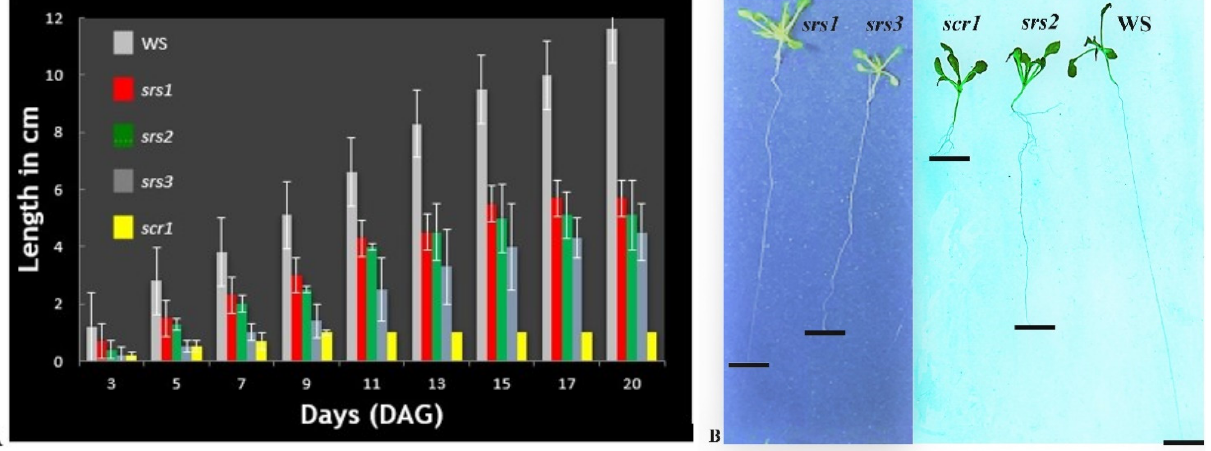
Figure 4. Root growth analysis of A. thaliana . ( A ) Root growth of WS, srs1–3 and scr1 were measured at different time points (points at the X-axis). Three suppressors srs1 , srs2 and srs3 exhibit significantly longer roots than scr1 but shorter than WS. Error bars represent means ± standard deviation (SD). ( B ). Root length of srs1 , srs3 , scr1 , srs2 , and WS at 20 days after germination (DAG).